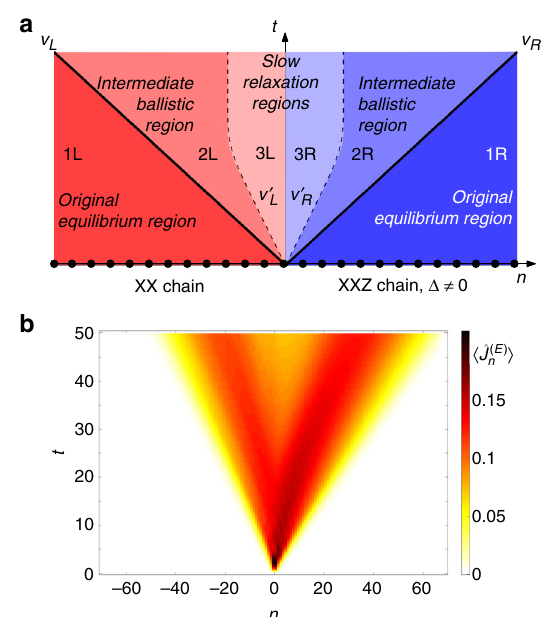
Fig. 1 Transport in inhomogeneous spin chains. a An inhomogeneous quantum spin-1/2 chain composed of an XX and of an XXZ half is initialized in a pure state with energy or magnetization imbalance and subsequently evolved in time. The relaxation dynamics inside the light cone (thick black lines, velocities v L ; R ) witnesses the coexistence of two (intermediate) ballistic regions and of two slow relaxation regions. The slow dynamics initially takes place inside an internal light cone with velocities v 0 L ; R , while, at long times, the extension of these regions remains constant in time. b long enough times, a decay of the current at the junction appears as